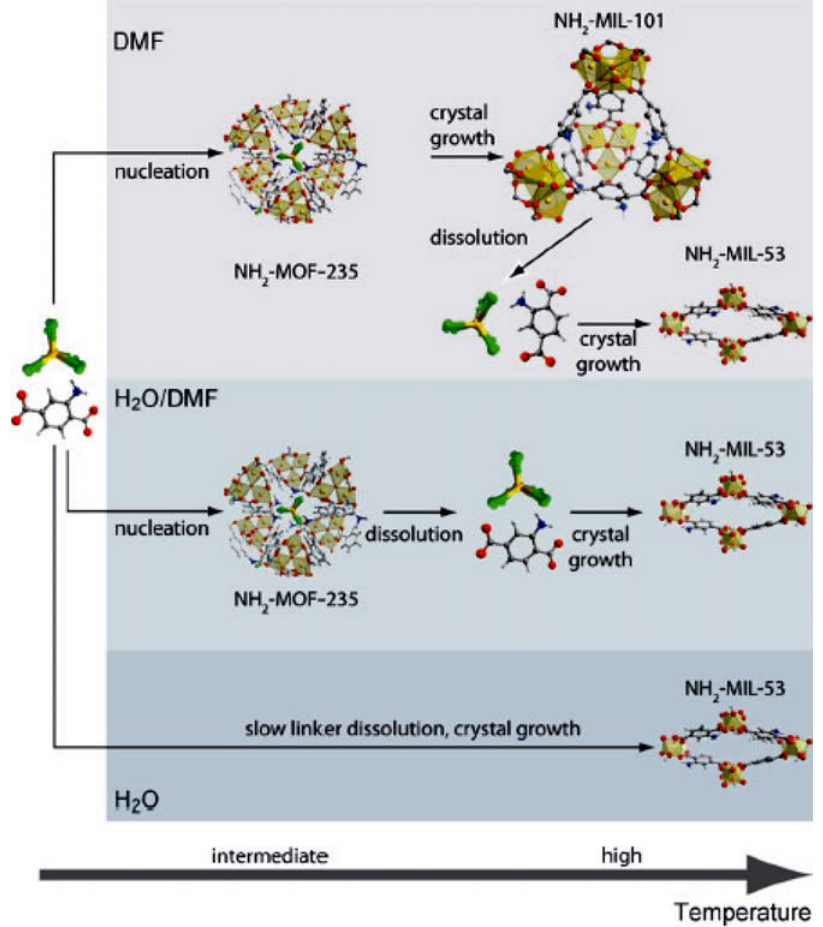
Figure 3. The sequence of events during the crystallization of terephthalate-based MOFs in different media: Low precursor concentrations (DMF); O/DMF or H O). 50 Reprinted with permission. Copyright John Wiley and high precursor concentrations (H 2 2